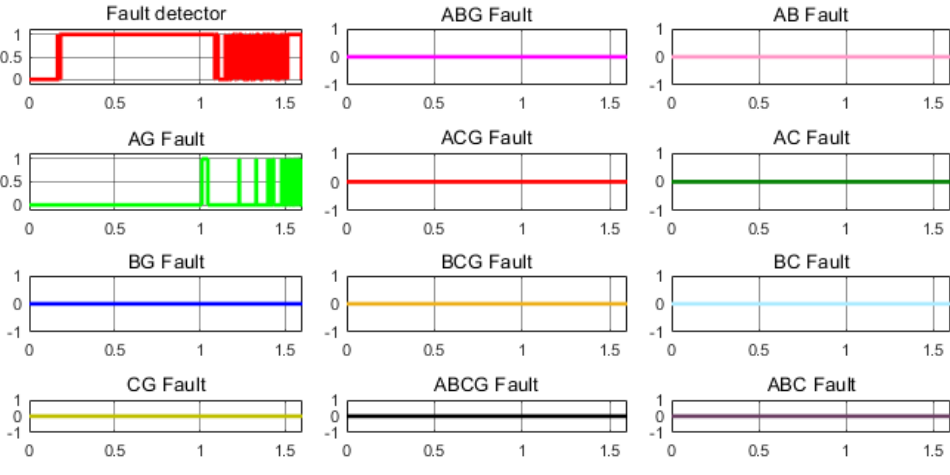
Figure 9. a-g Fault detected.